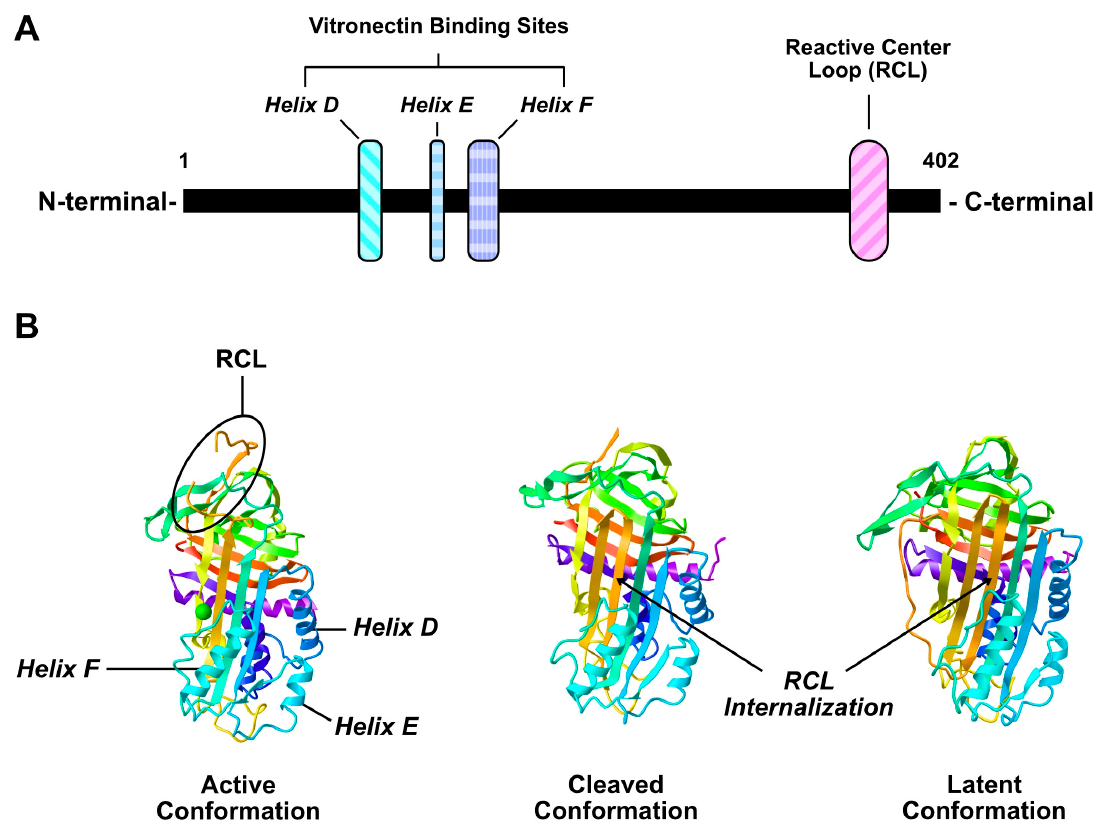
Figure 1. Illustration of plasminogen activator inhibitor-1 (PAI-1) linear ( A ) and crystalline ( B ) structure. Crystalline structure adapted from [101,102].